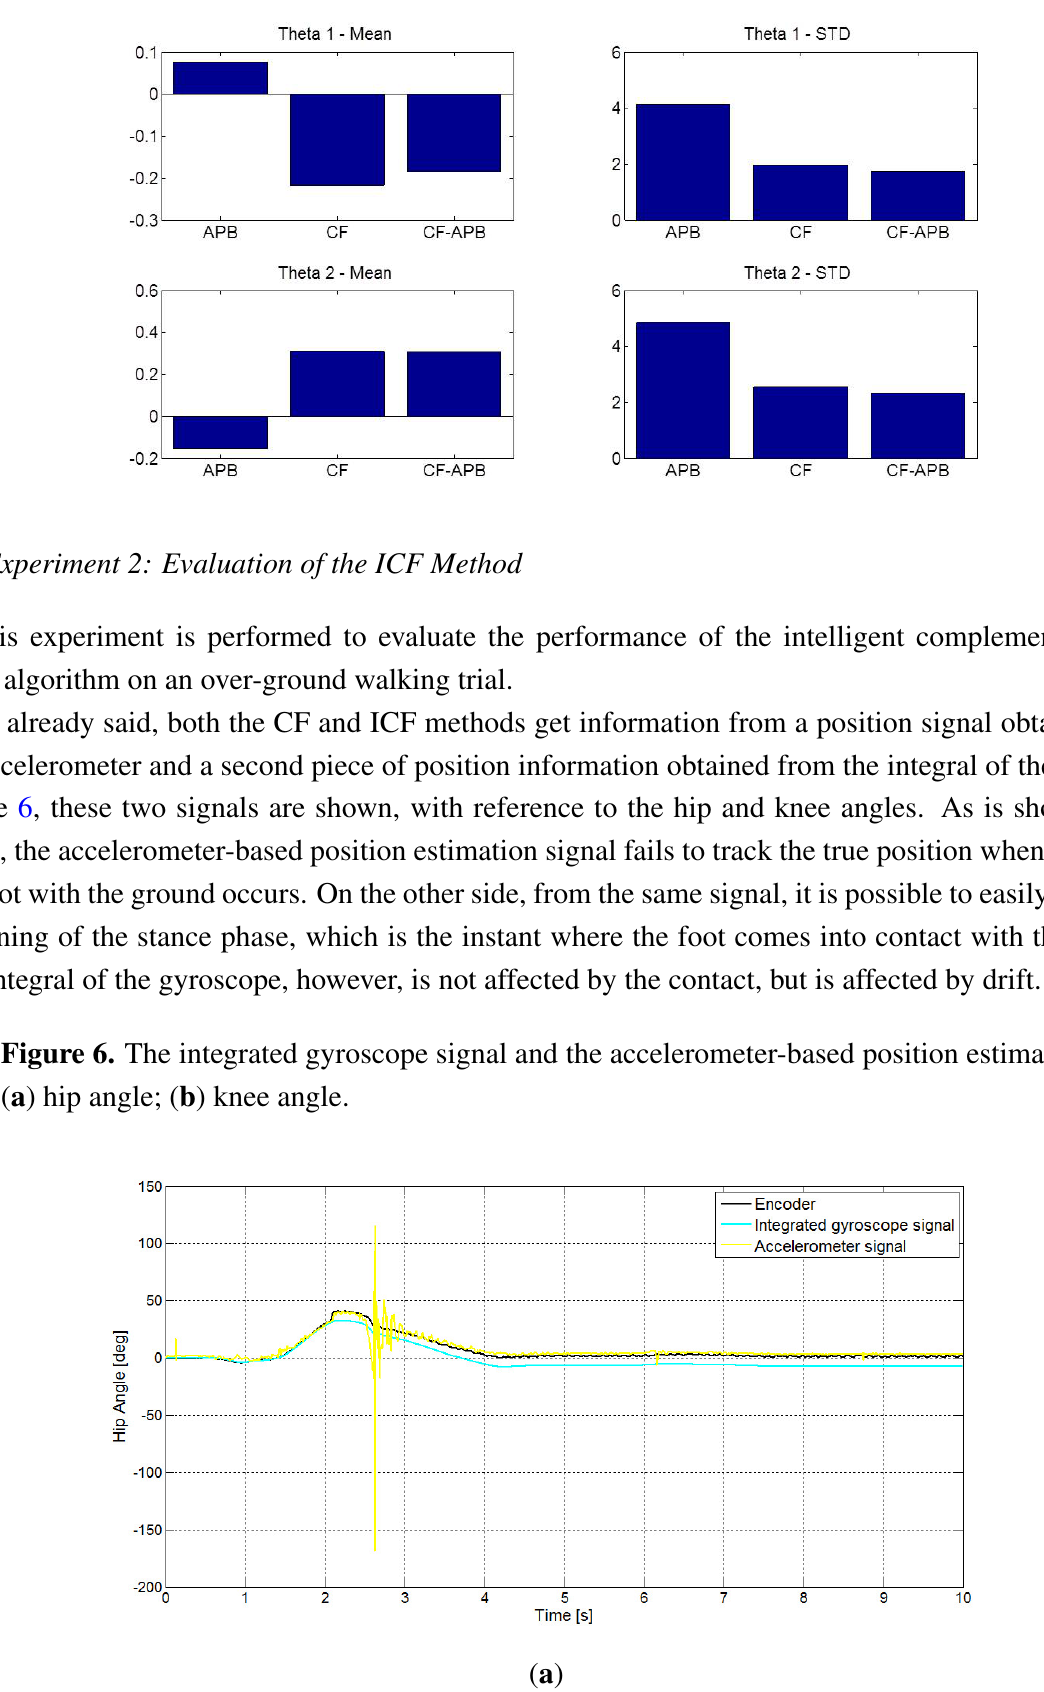
Figure 5. Statistic comparison between APB, CF and both bound together (CF-APB).